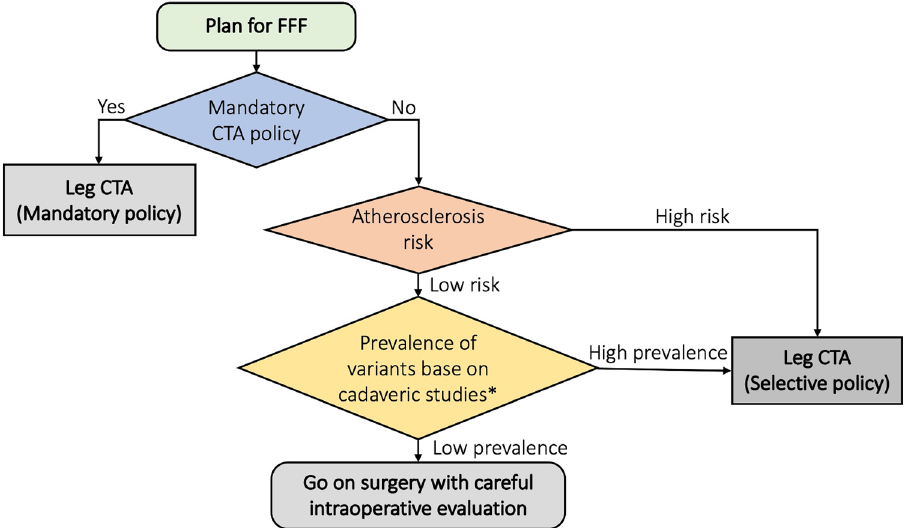
Figure 2. A schematic overview of pre-operative leg CTA in fibular free flap harvesting. If mandatory leg CTA policy is not applicable, which might be from the low prevalence of variants, limited contrast media amount from renal impairment, the leg CTA should be done following an atherosclerosis risk assessment. *The decision-making at this point should be based upon cost-effectiveness 8,14 of leg CTA and prevalence in each population. To elaborate, in the low-risk for atherosclerosis group, the prevalence of variants should be referred from cadaveric studies since the prevalence is similar to the congenital prevalence. By contrast, patients at risk for atherosclerosis have a higher rate of acquired variants. FFF fibular free flap, CTA computed tomography